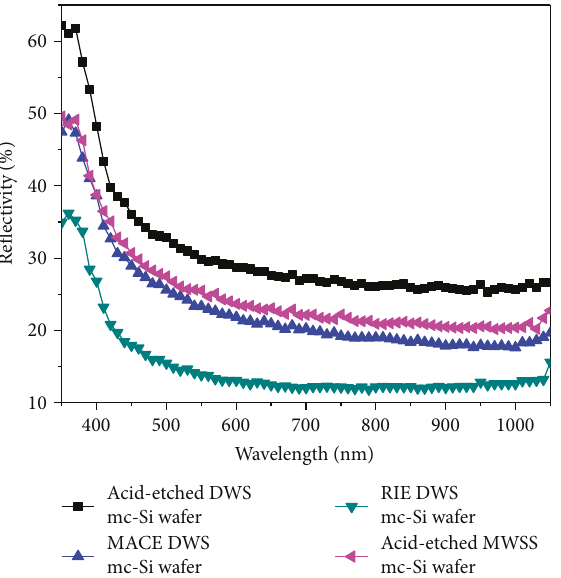
Figure 2: Re fl ectivity versus wavelength curves of wafers with di ff erent